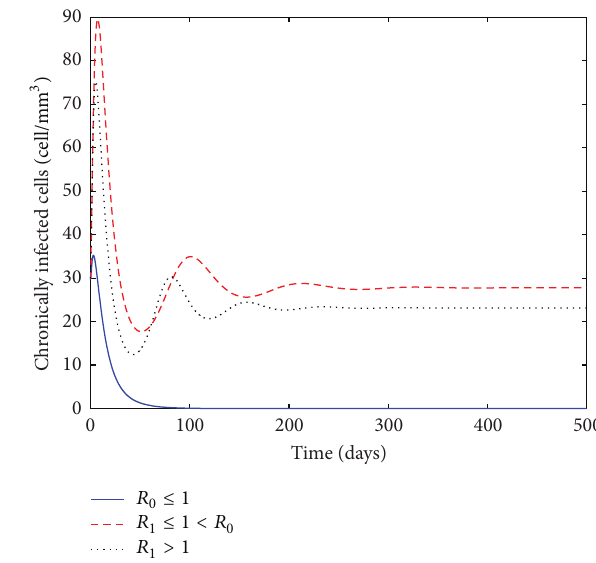
Figure 1: The evolution of uninfected cells for model (2)–(6).